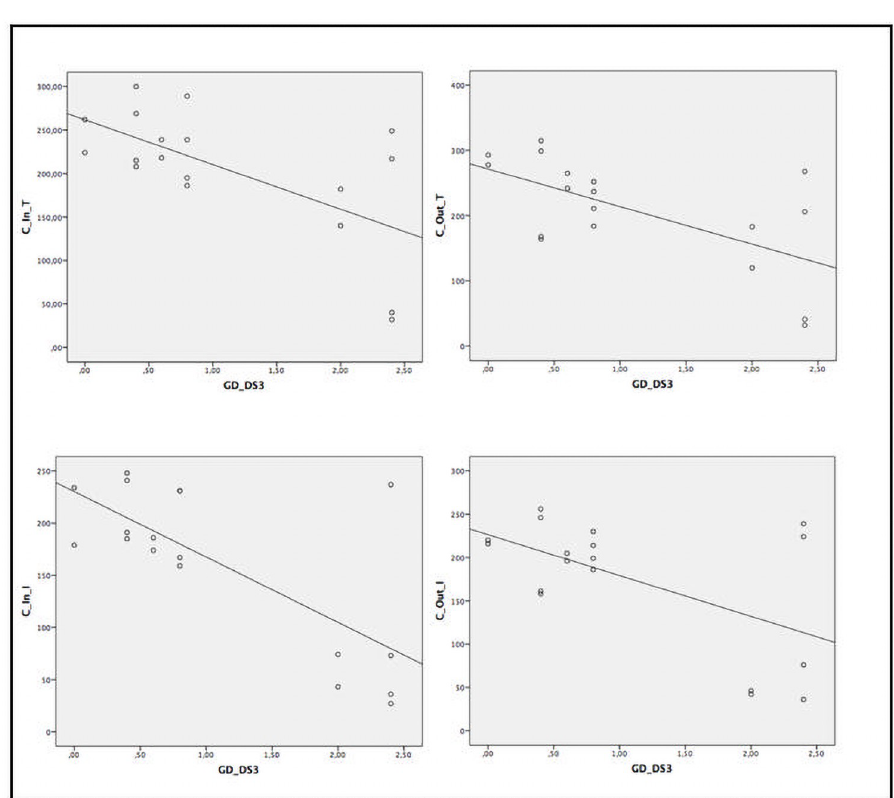
Fig 4. Moderate and strong correlation (r > 0.6) between choroidal thickness by SS-OCT and GD-DS3